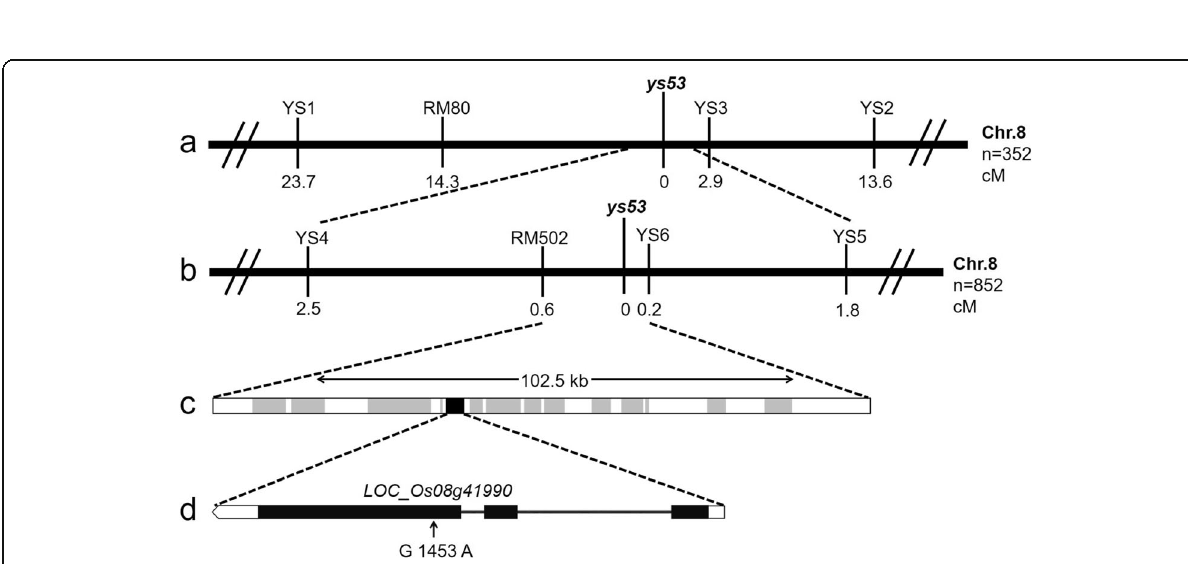
Fig. 3 Map-based cloning of the ys53 locus. a The ys53 locus was mapped to the long arm of rice chromosome 8 using 352 F 2 yellow-leaf individuals. b This locus was further mapped to a 102.5-kb region between SSR marker RM502 and InDel marker YS6 using 852 F 2 yellow-leaf individuals. c This region contains 14 putative genes. d Candidate gene LOC_Os08g41990 comprises three exons and two introns, in which a single nucleotide G-to-A substitution occurred at position 1453 of its coding region in the